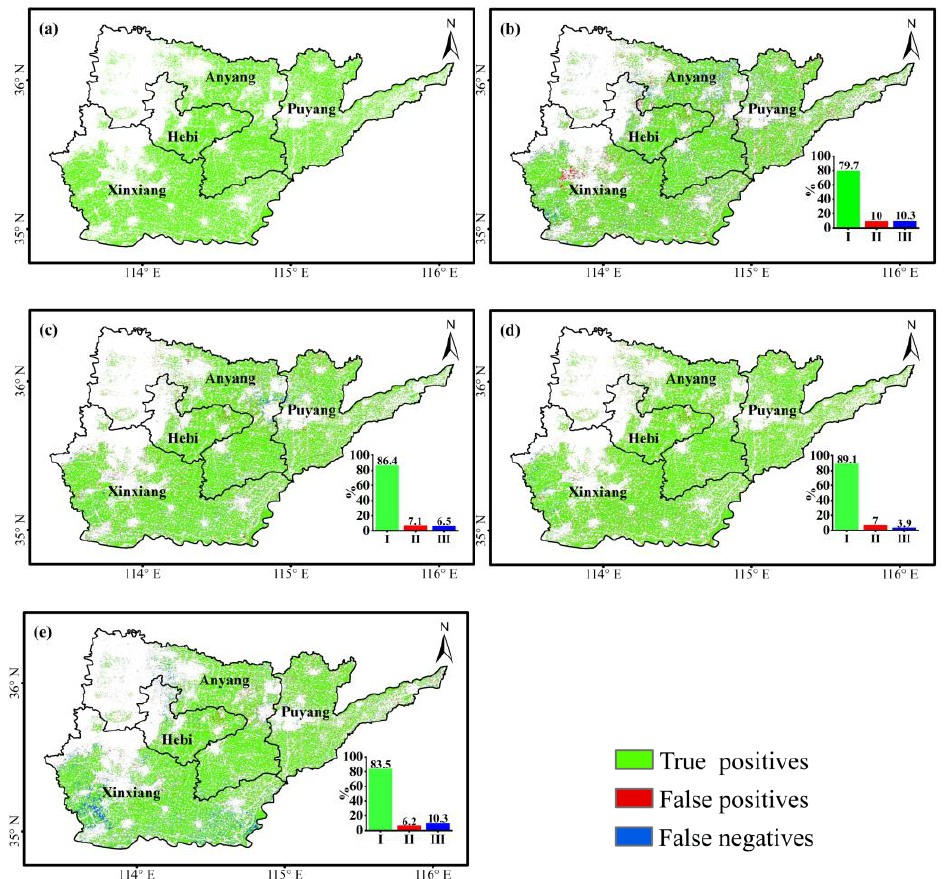
Figure 8. Mapping of winter wheat based on deep learning classification. (a) U-Net classification map of winter wheat for the jointing-heading period (reference image); it was subtracted from the winter wheat classification map corresponding to other periods to generate difference maps (b-e). In the bar charts, I, II and III represents the ratio of the number of correctly predicted, wrongly predicted and ‘missing’ winter wheat pixels to the union of the number of predicted winter wheat pixels and the true number, respectively.